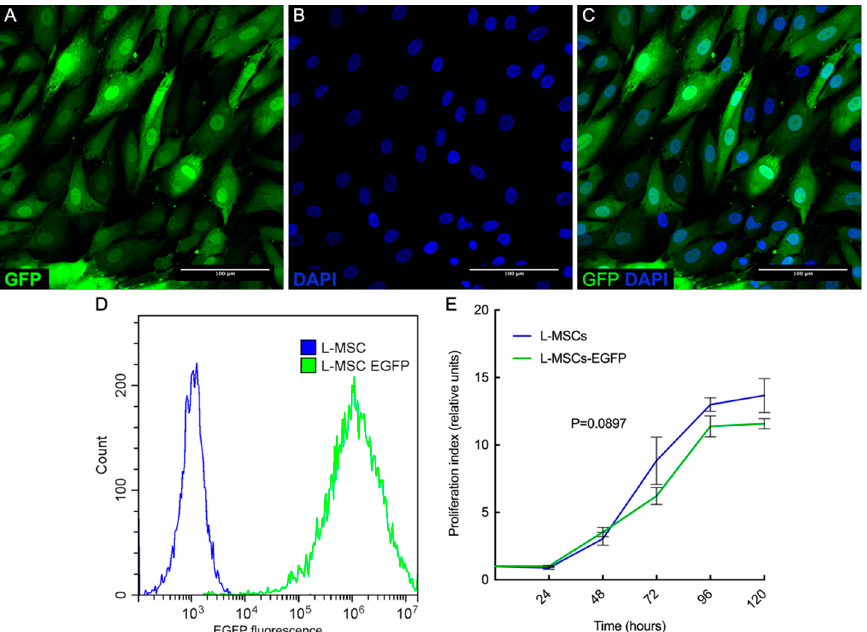
Figure 2. Analysis of L-MSCs with overexpression of green fluorescent protein (L-MSCs-EGFP). ( A – C )—confocal microscopy of fixed L-MSCs-EGFP stained with DAPI (Scale bar—100 μ m). ( A ) GFP channel. ( B ) DAPI channel. ( C ) Merge of two channels (GFP + DAPI). ( D ) Flow cytometric analysis of L-MSCs and the population of L-MSCs-EGFP after cell sorting. In GFP-channel the high fluorescence intensity of EGFP protein in the entire population of L-MSCs-EGFP was shown. The blue curve corresponds to L-MSCs, and the green curve corresponds to L-MSCs-EGFP. Curves describe the intensity of the EGFP fluorescence signal in the cell populations. ( E ) Cell proliferation assay of rabbit L-MSCs and L-MSCs-EGFP. There were no significant differences in cell proliferation rates ( p < 0.09).